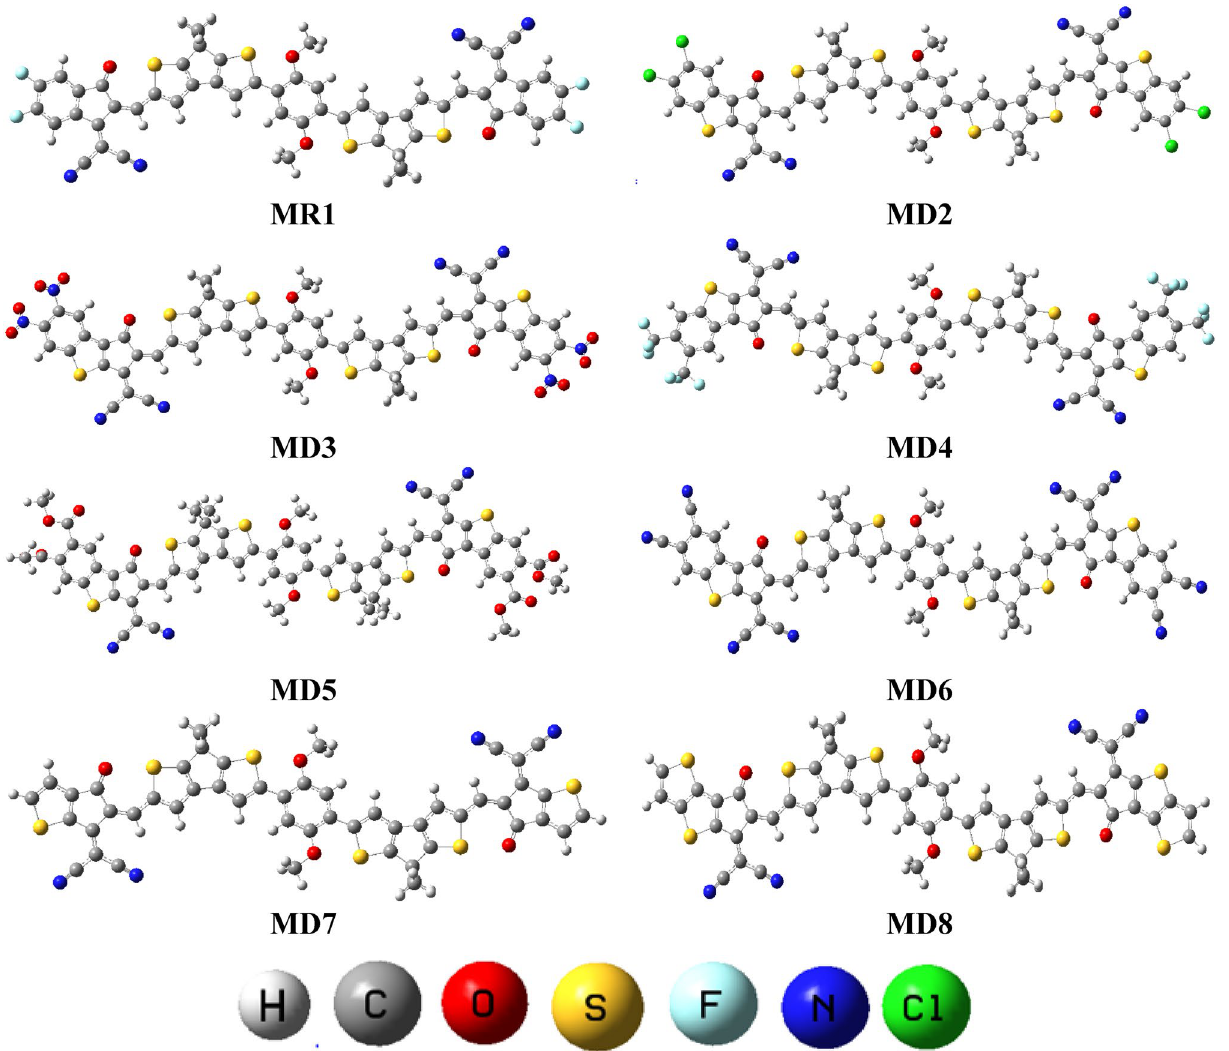
Figure 3. The optimized structures of all theoretically designed compounds. Figures are made with are made with the help of GaussView 5.0 and Gaussian 09 version D.01 (https:// gauss ian. com/ g09ci tation/).